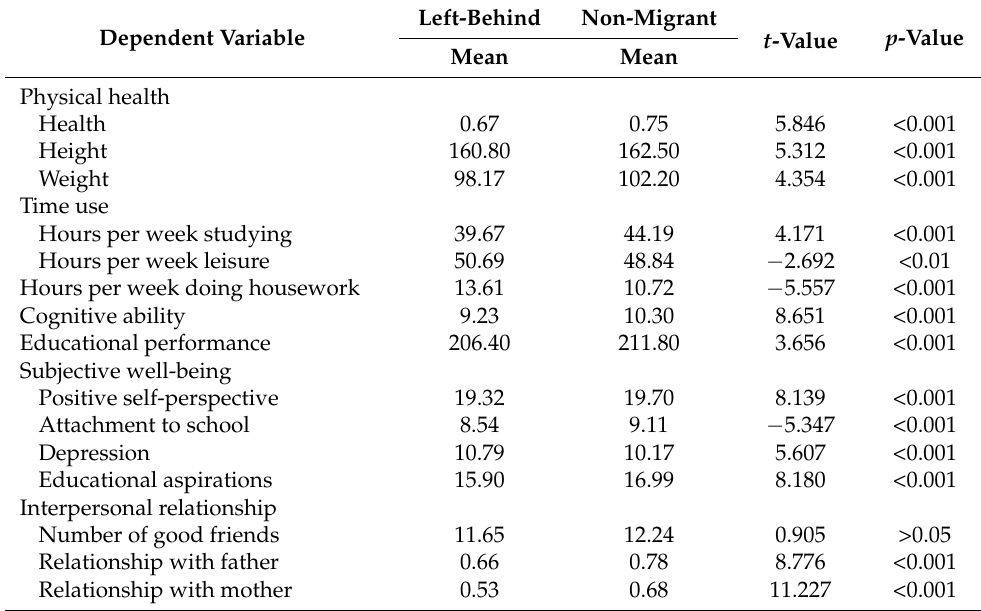
Table A2. The t -test of the outcome variables in the analytical sample of urban children (N = 7527). Dependent Variable